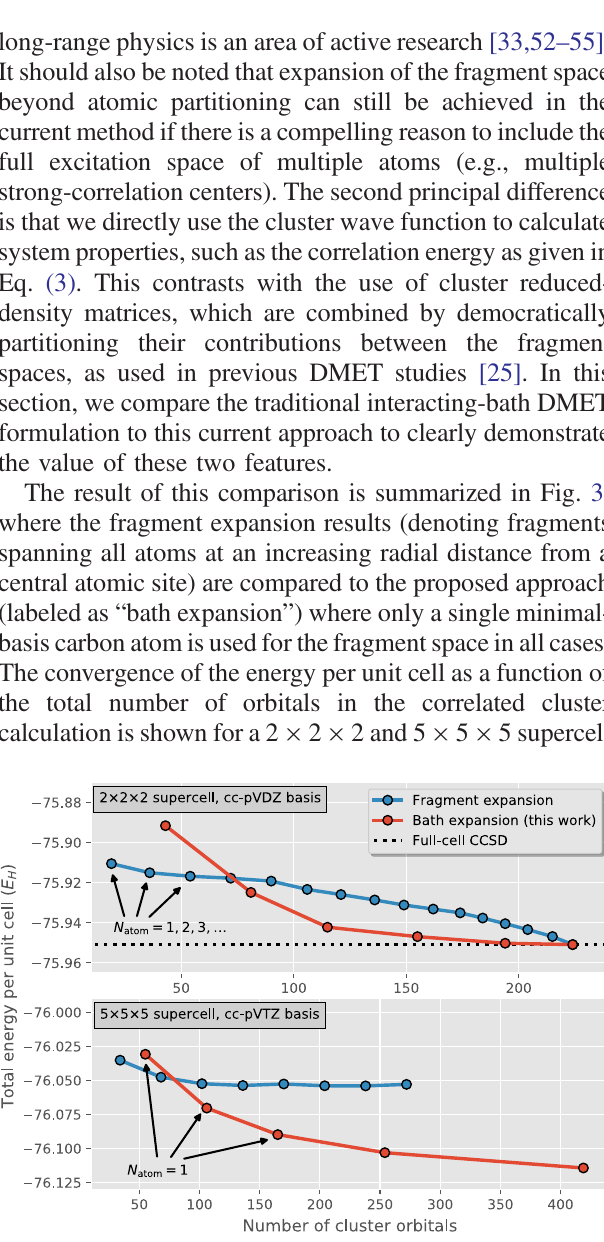
FIG. 3. Convergence of the total energy per unit cell of diamond for a given number of correlated cluster orbitals, comparing an expansion of the fragment space to the proposed approach based on an expansion of the bath space via cluster- specific natural orbitals. Top plot shows convergence to the full- cell result in a 2 × 2 × 2 supercell and cc-pVDZ basis, while the lower plot shows the convergence in a 5 × 5 × 5 supercell and cc- pVTZ basis. The fragment expansion relies on inclusion of sets of IAO þ PAO fragment orbitals on all included atoms, while the bath expansion has a fragment space of a minimal IAO space of a single-carbon atom ( N in the plot denotes the number of atom atoms included in the fragment). Energies in the fragment expansion are computed from democratically partitioned density matrices [25] requiring an additional chemical-potential optimi- zation, while the bath expansion energies are computed as defined in Sec. II